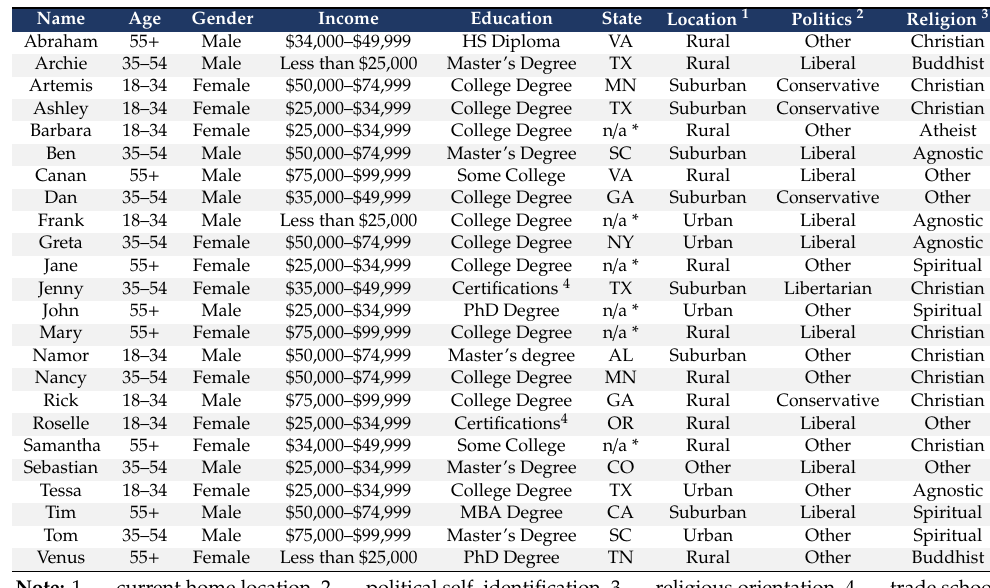
Table A1. The Social Profile of